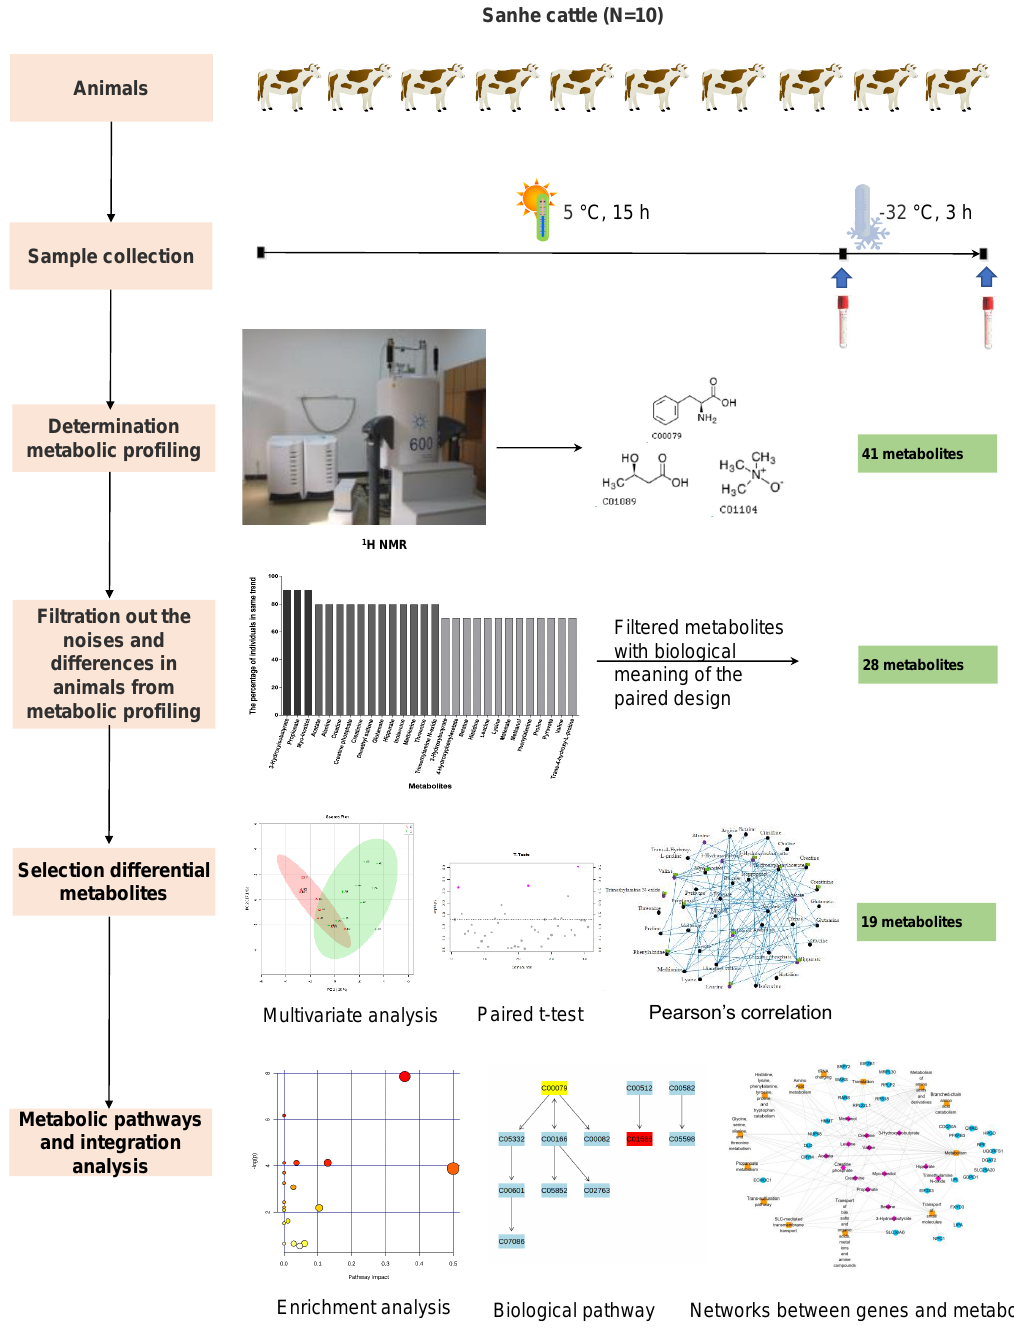
Figure 1. The analytical workflow performed in this